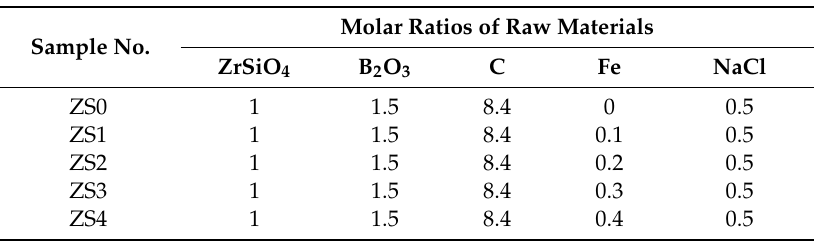
Table 1. Molar ratios of raw